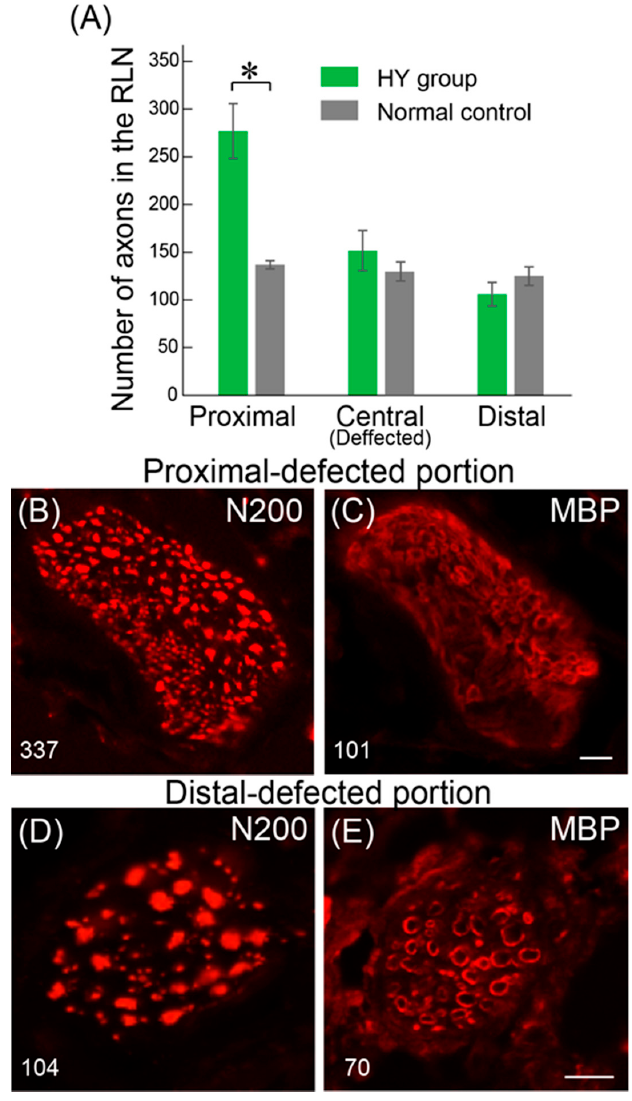
Figure 4. Quantitative analysis of the RLN in the proximal-, central- and distal-portion of nerve- defected area of the HY group. ( A ) The number of axons was gradually decreased following the order of proximal-, central- and distal-portions. The double score is detectable in the proximal-portion, but the score is similar or less in the central and distal-portion in the HY group in comparison to the normal intact control. * p < 0.01. Typical photographs of proximal- and distal-potions are shown in ( B – E ). Proximal-portion show a 337 axon (N200) count and 101 myelin (MBP) count. The